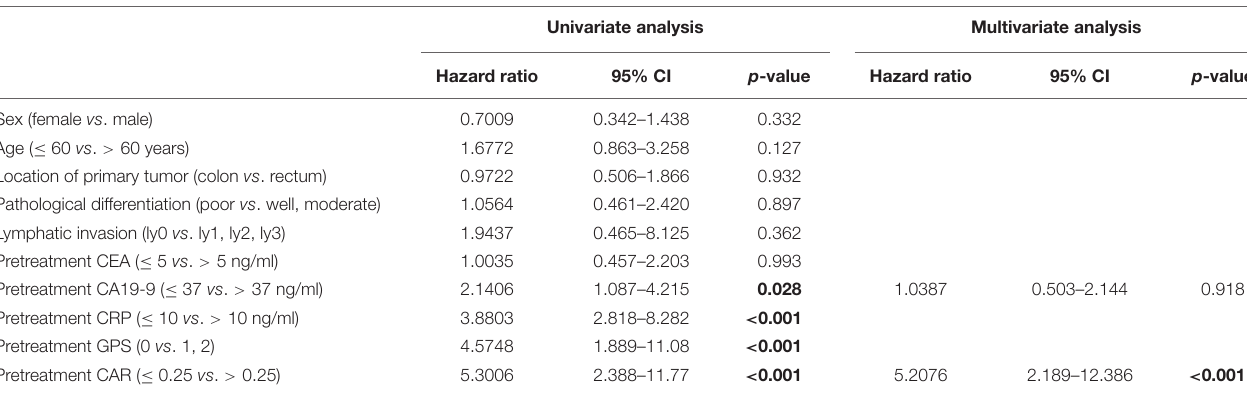
TABLE 5 | Correlations between overall survival and the clinicopathological factors in CRLM